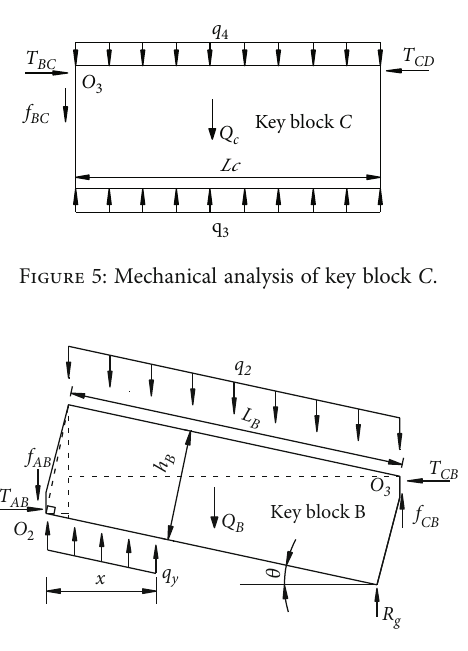
Figure 6: Mechanical analysis of key block B .